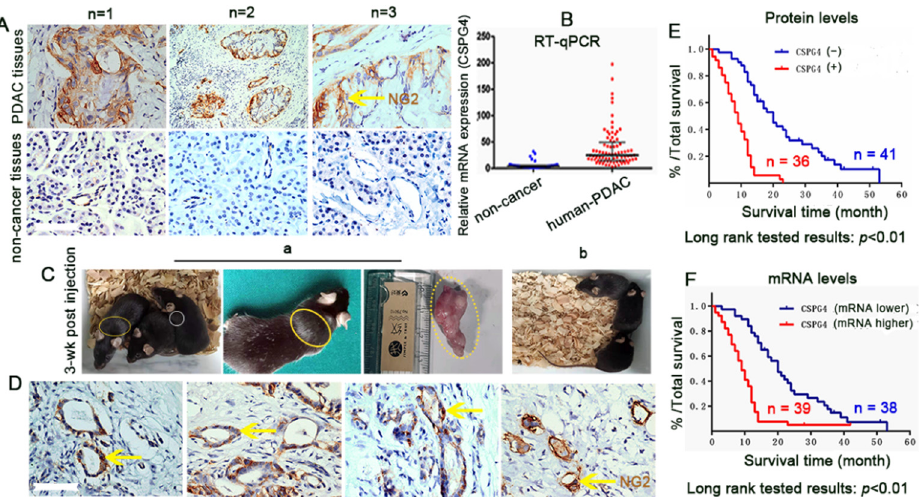
Figure 3. NG2/CSPG4 overexpression in pancreatic ductal adenocarcinoma (PDAC) predicts a poor prognosis. ( A , B ) 3,3’-Diaminobenzidine (DAB) staining (brown) and RT–qPCR for NG2/CSPG4 identification in PDAC patient tissues (top panel) and non-cancerous pancreatic tissues (low panels) at both the protein ( A ) and mRNA ( B ) levels, respectively. Scale bar = 100 µm. ( Ca , b ) Tumorigenesis of human hepatocellular carcinoma (HCC) cell lines (H 22 ) in C56BL/6 mice injected with the NG2- isolated (NG2 + /H 22 ) cell line. In total, two (indicated by an yellow oval and a white circle) out of three mice developed tumors two weeks after cell injection ( Ca ), while control mice that received non-NG2-isolated cell lines (H 22 ) ( Cb ) remained cancer-free at the same time. ( D ) The expression of NG2/CSPG4 was closely related to the intra-vessel space. Scale bar = 100 µm. ( E , F ) Overexpression of NG2/CSPG4 in PDAC at both the protein ( E ) and mRNA ( F ) levels predicted poor survival.